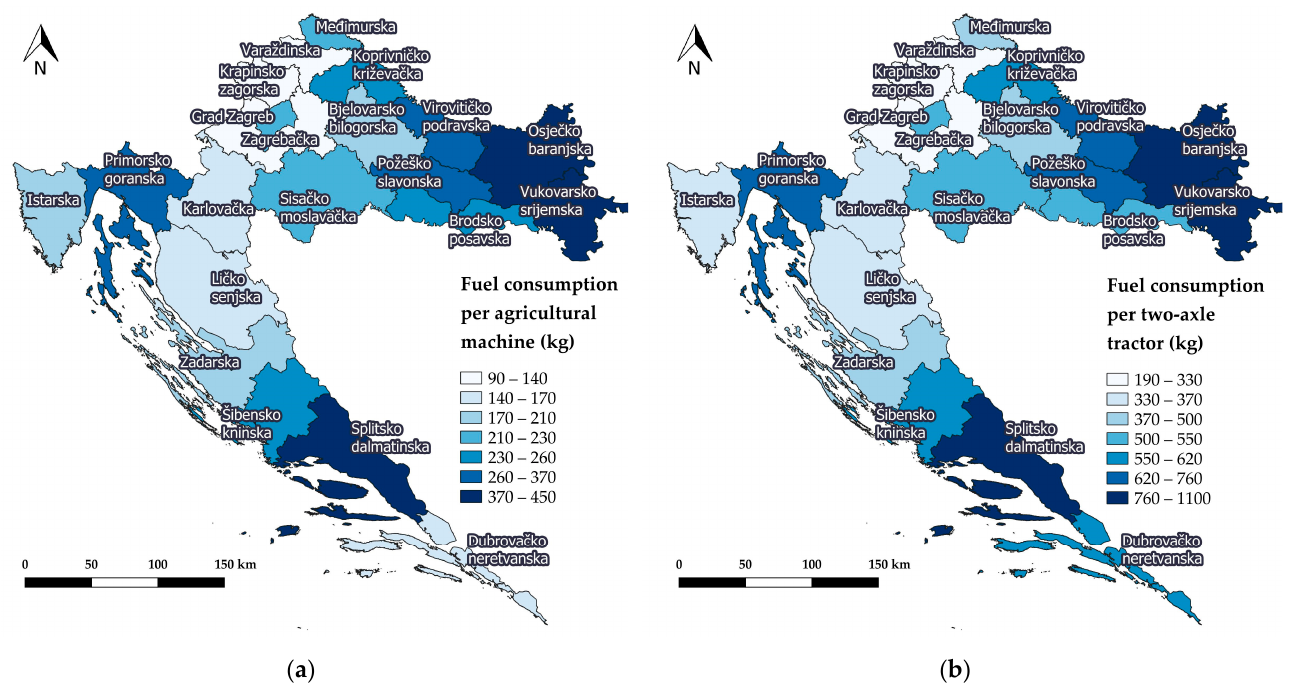
Figure 3. Spatial distribution of the fuel consumption per agricultural machine ( a ) and fuel con- sumption per two-axle tractor ( b ) in tons of fuel.